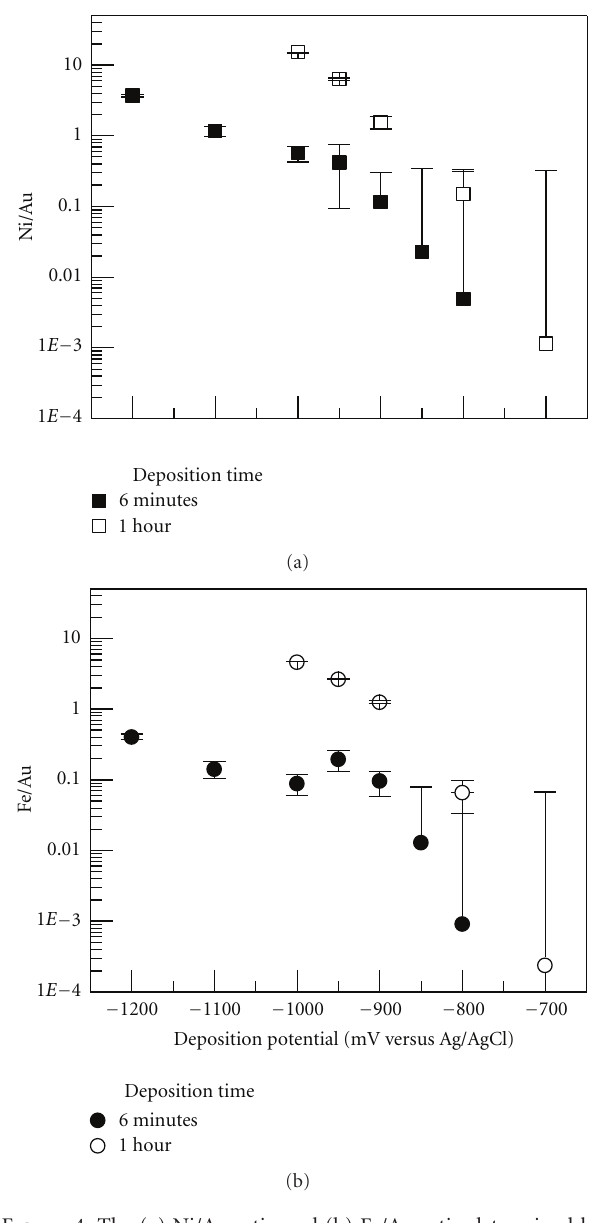
Figure 4: The (a) Ni/Au ratio and (b) Fe/Au ratio determined by PIXE as a function of the deposition potential for two di ff erent deposition